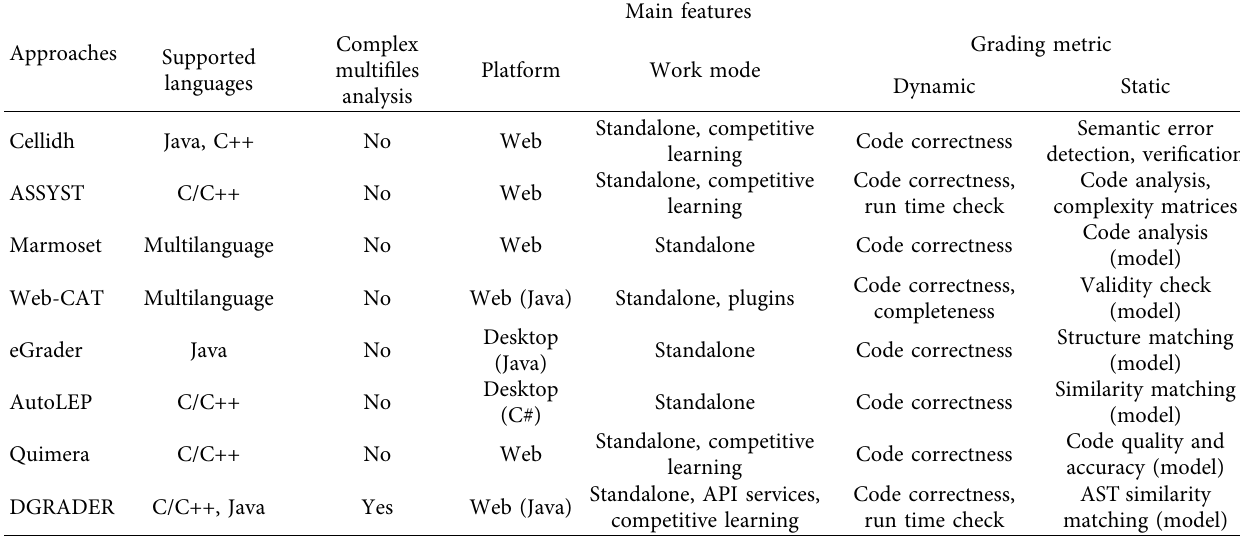
Table 12: Existing similar program comparison (main